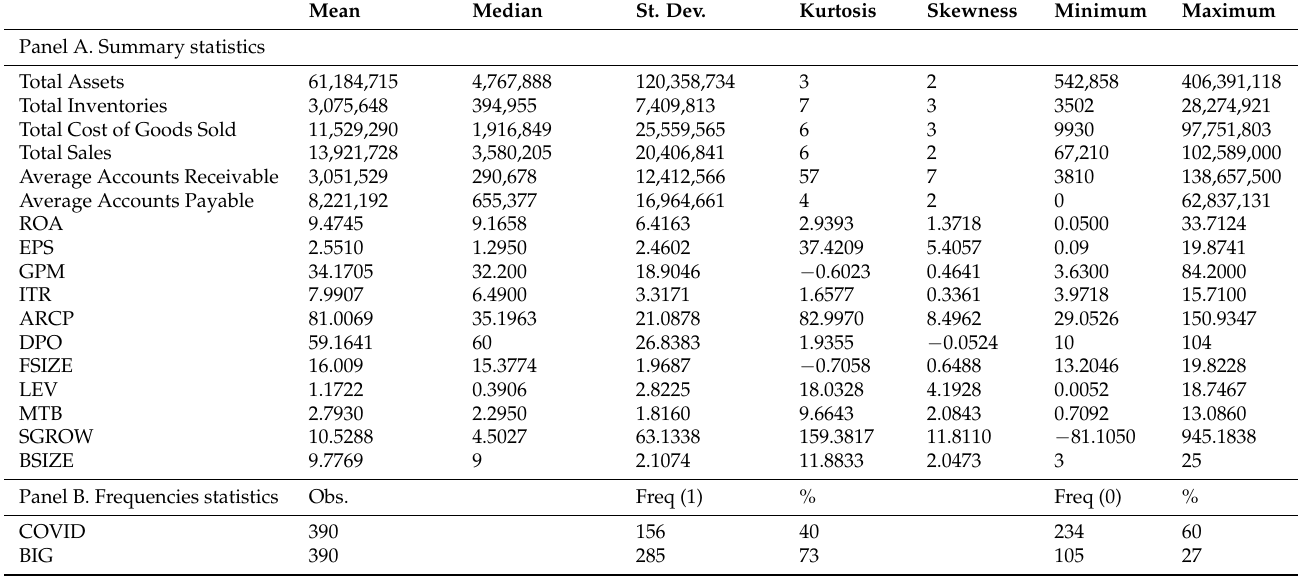
Table 2. Descriptive summary.